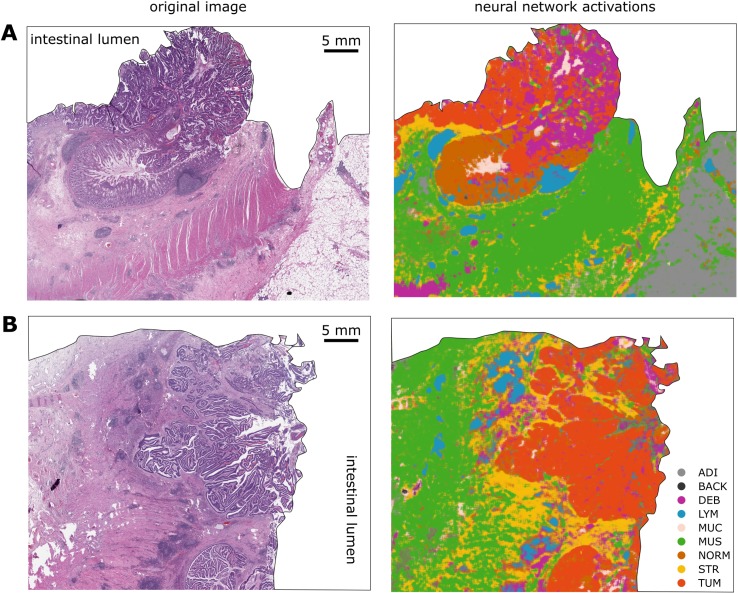
A CNN can segment histopathological whole-slide images.The neural network classifier was used to classify real-world images from the DACHS cohort. (A) and (B) show two representative example images. Left: original HE image; right: classification map. Even fine structures are recognized by the neural network even in regions of suboptimal tissue quality. Only the tissue is shown in this example, and because the tissue does not occupy a rectangular area on the pathology slide, the whole-slide image was manually segmented by an observer trained in pathology to show only tissue without background for better clarity (background is white). ADI, adipose tissue; BACK, background; CNN, convolutional neural network; DACHS, Darmkrebs: Chancen der Verhütung durch Screening; DEB, debris; HE, hematoxylin–eosin; LYM, lymphocyte aggregates; MUC, mucus; MUS, muscle; NORM, normal mucosa; STR, stroma; TUM, tumor epithelium.